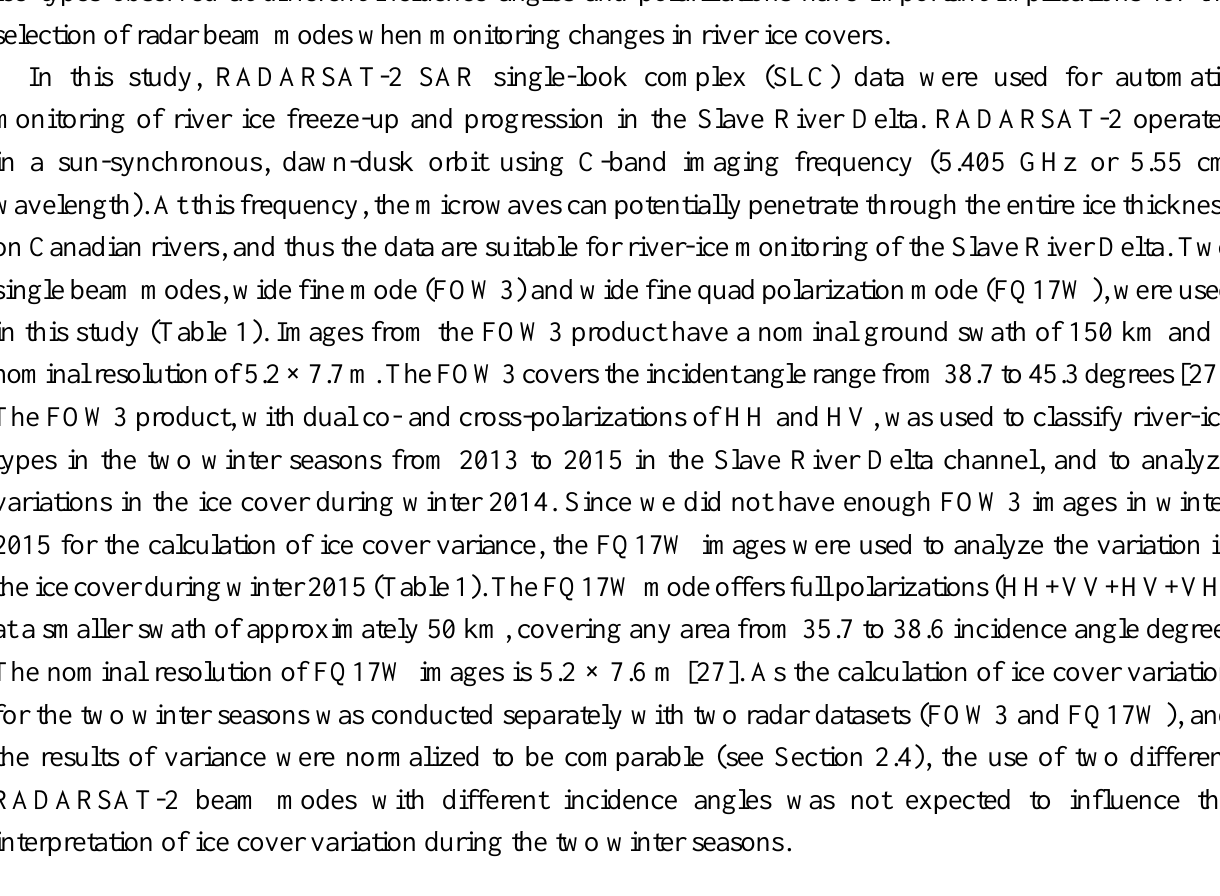
Table 1. RADARSAT-2 data for monitoring freeze-up and ice cover progression during winter 2014 and winter 2015 in the Slave River